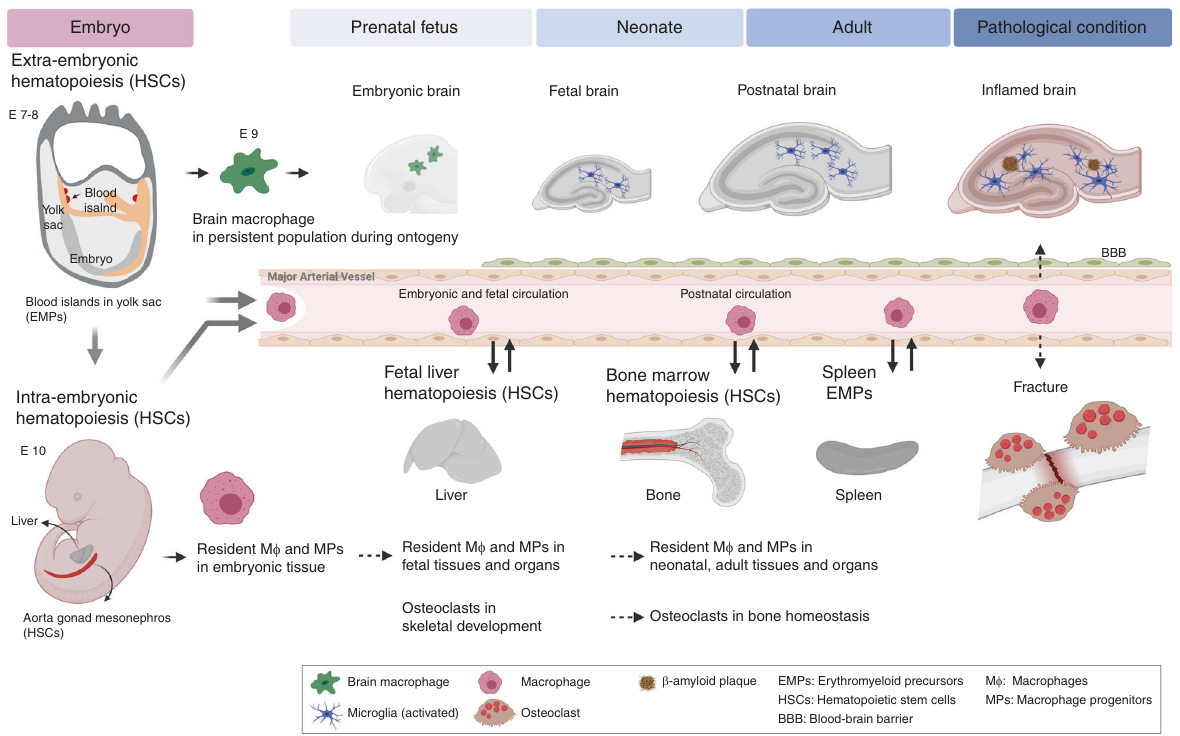
Fig. 1 Developmental overview and homeostasis regulations of osteoclasts and microglia. Primitive macrophages exit blood islands of the yolk sac (YS) with the initiation of circulation and colonized the neuroepithelium from E8.5 to give rise to microglia. In a steady state, YS-derived macrophages are differentiated into microglia which, in turn, self-renew throughout ontogeny until adulthood. Under pathological conditions, circulating progenitors or resident macrophages that are allowed to reside in brain contribute to newly differentiated microglia. The migration of de fi nitive brain macrophage is initiated from the HSCs of the embryonic aorta-gonad-mesonephros (AGM). Subsequently, HSCs expand in the fetal liver, which is the main source for tissue-speci fi c macrophages. Osteoclasts originated from resident embryonic- myeloid progenitors (EMPs) lineage, which are long-lived and can participate in postnatal bone maintenance. Adult bone homeostasis is maintained by osteoclast fusion that are derived from EMPs and HSCs supplied by bone marrow and possibly by spleen. In injured skeletal tissues, for instance due to bone fracture, circulating monocytes and macrophages from spleen migrate into damaged tissue and contribute to tissue Common signaling pathways between osteoclasts and microglia Osteoclasts and microglia diverge during development and differentiation according to their tissue microenvironments. Nonetheless, they share key signaling pathways of which three receptor signaling pathways — i.e., TREM2/DAP12, CSF1, and CCR5 — that converge to regulate actin-microtubule dynamics and cytoskeleton organization through Pyk2 signaling pathway (Fig. 2).